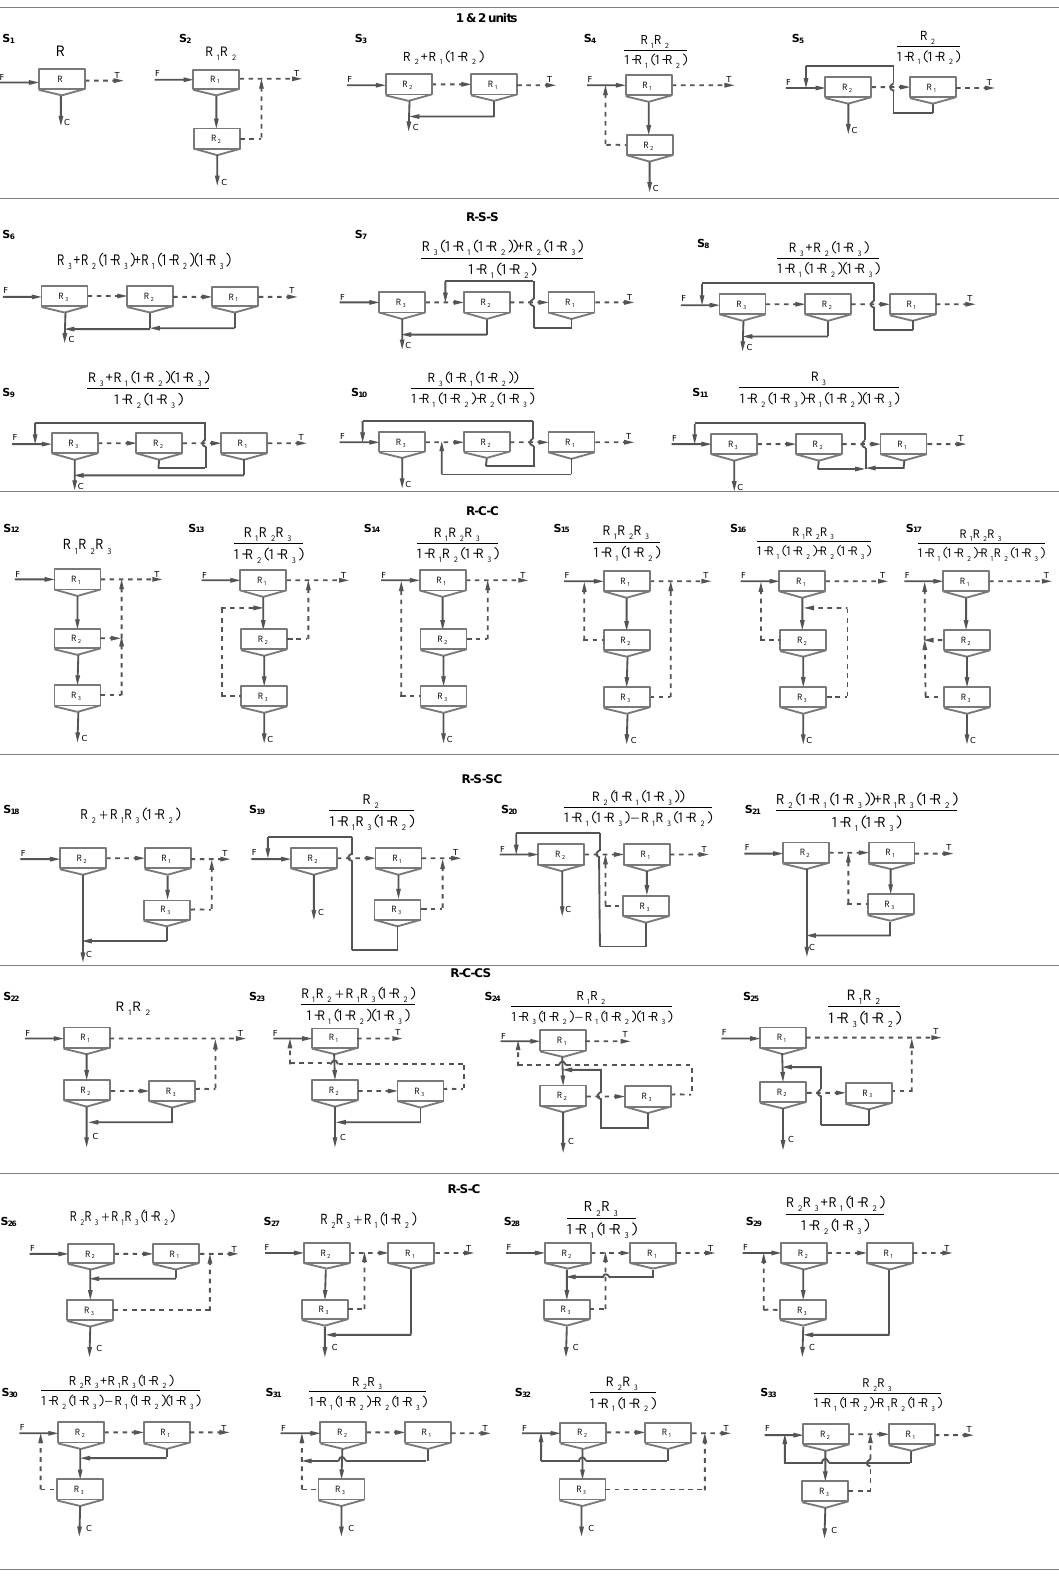
Figure 3. Simple circuit structures and their recovery function.